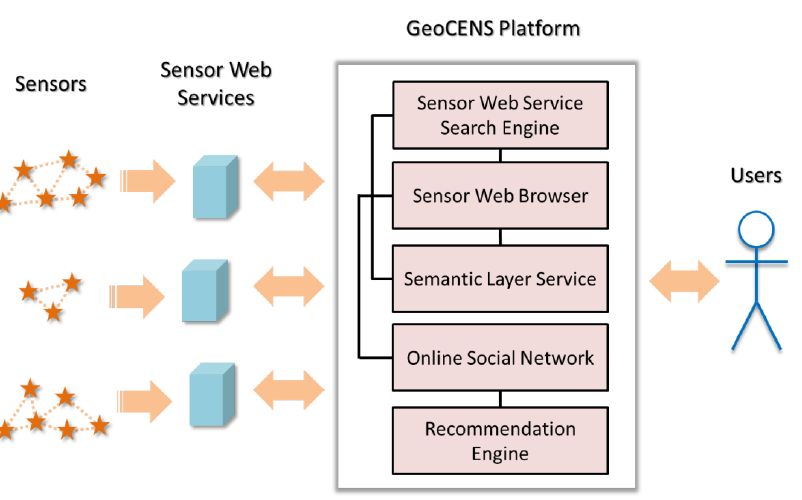
Figure 3. The GeoCENS